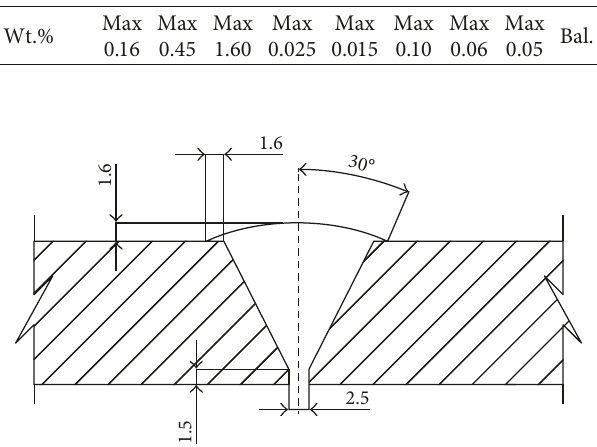
Figure 1: Groove